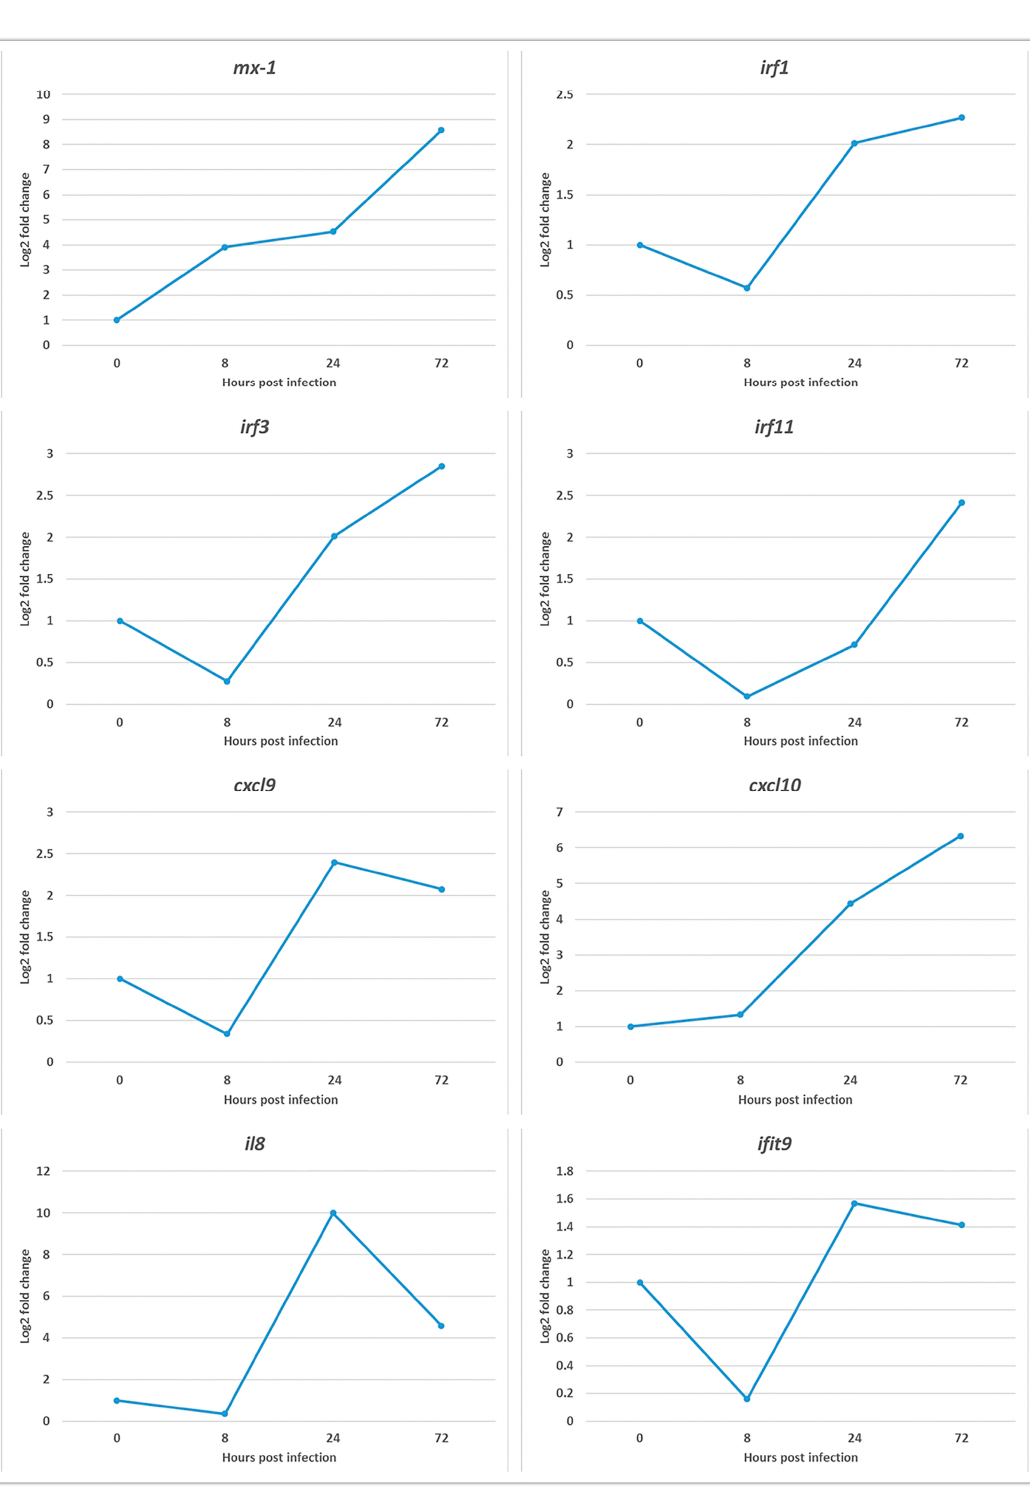
Figure 5. Expression patterns of key genes involved in immune responses. Expression pattern of eight interferon-related genes including interferon-inducible Mx protein 1 ( mx-1 ), interferon regulatory factor 1 ( irf1 ), interferon regulatory factor 3 ( irf3 ), interferon regulatory factor 11 ( irf11 ), C–X–C motif chemokine 9 ( cxcl9 ), C–X–C motif chemokine 11 ( cxcl10 ), interleukin 8 ( il8 ), interferon-induced protein with tetratricopeptide repeats 9 ( ifit9 ) were examined.